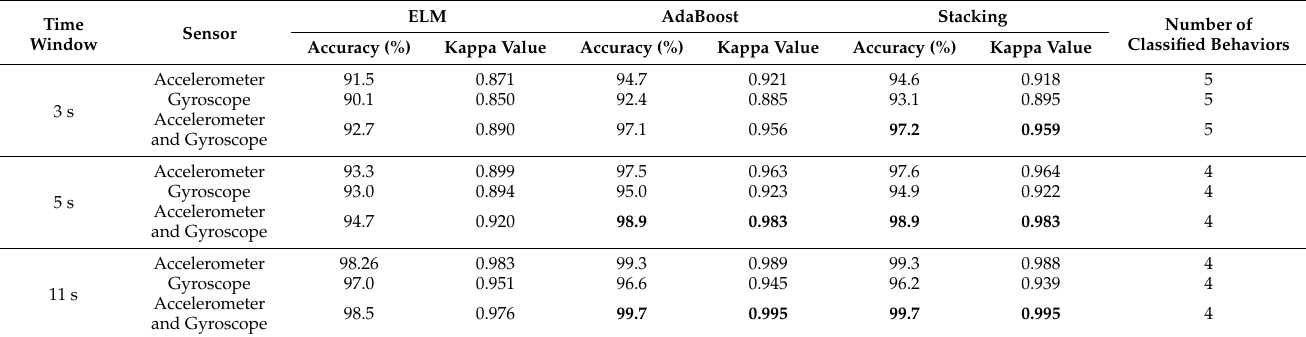
Table 5. Summary of accuracy and kappa values for different ML predictions of walking, standing, grazing, lying and running at 3, 5 and 11 s time windows on the test dataset. Bold indicates the highest accuracy and Kappa values